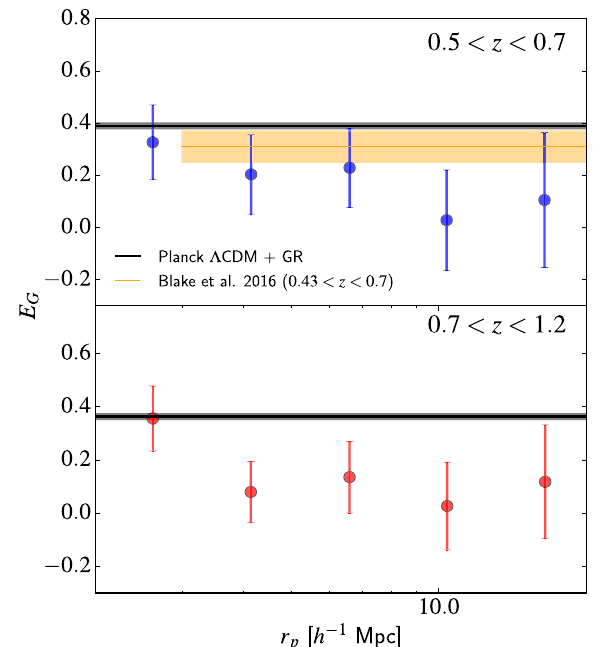
Fig. 10 E G parameter as function of scale in redshift range 0 . 5 < z < 0 . 7 (top panel) and 0 . 7 < z < 1 . 2 (bottom panel) as measured in de la Torre et al. (2016). In the two panels, the solid curves and shaded areas around them correspond to the prediction and the 68% uncertainty (thin grey) band for GR with a Λ CDM backgroundsettothebestfitmodelofTT + lowP + lensingPlanck2015(Adeetal.2016a).Inthetoppanel, the horizontal (light brown) stripe shows the averaged E G over the range 3h − 1 Mpc < r p < 50h − 1 Mpc from Blake et al. (2016b) at redshift 0 . 43 < z < 0 . 7. Figure reproduced with permission from de la Torre et al. (2016). As they comment there, this measurements of E G are slightly lower (1 − 2 σ ) than expected